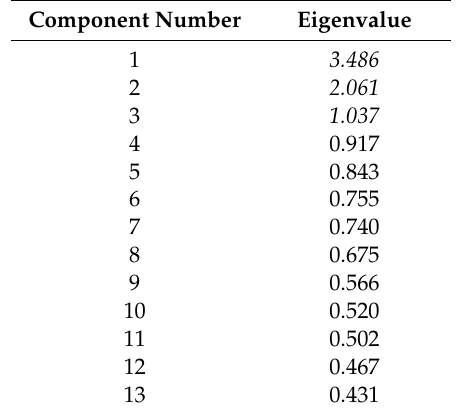
Table 2. Eigenvalues and the extracted number of components before factors rotation.